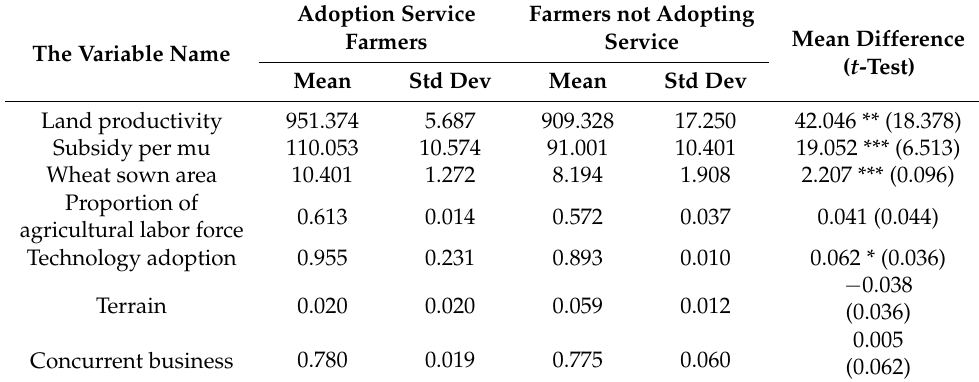
Table 2. The difference between farmers who adopt socialized agricultural machinery services and those who do